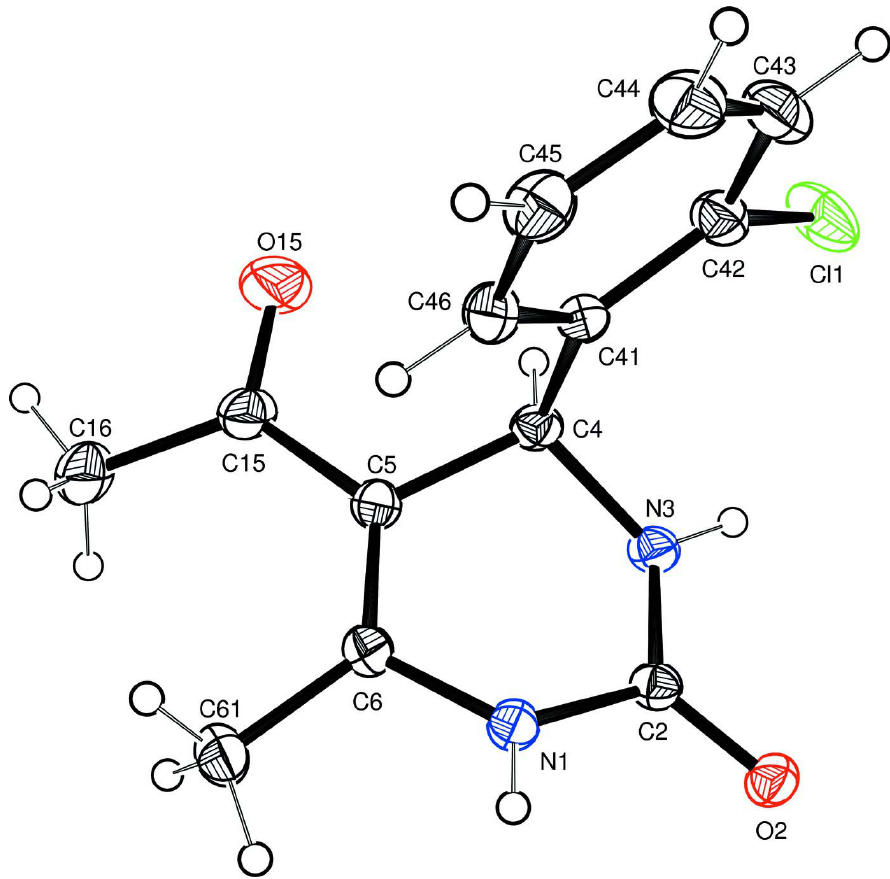
Figure 1 The molecular structure of (I), showing the atom-numbering scheme and displacement ellipsoids drawn at the 30% probability level. H atoms are shown as small spheres of arbitrary